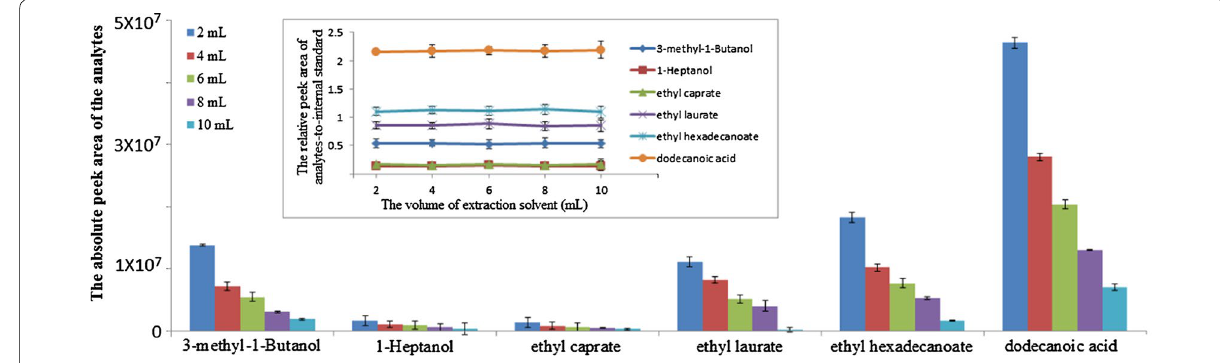
Fig. 3 Optimization of the extraction solvent